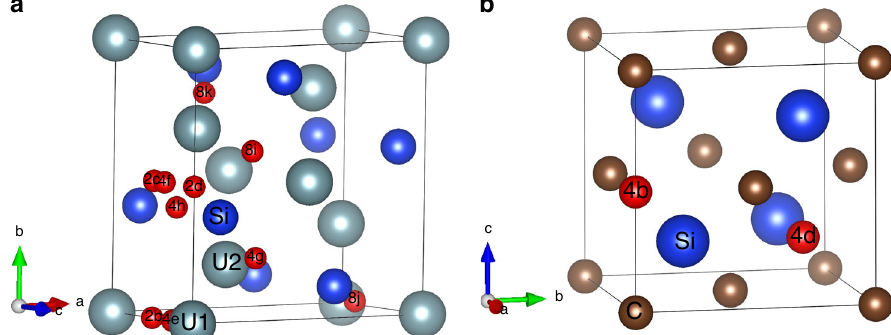
Fig. 3 Position of interstitial sites in U 3 Si 2 and SiC. Interstitial sites (red spheres) in ( a ) U 3 Si 2 , and ( b ) SiC treated as point defects in DFT calculations. The U, Si, and C atoms are shown as gray, blue, and brown, respectively.